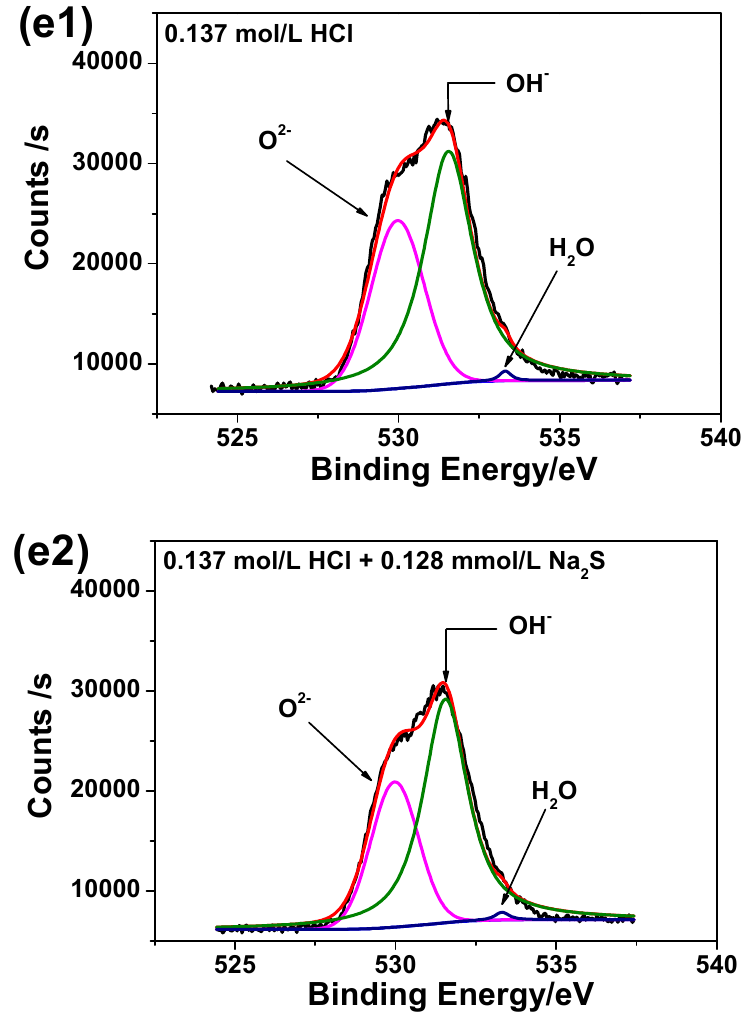
Figure 8. High-resolution scanning XPS spectra of passive films on 2205 DSS surface in 0.137 mol/L HCl solutions at 90 °C for 8 h: ( a1 ) Cr 2p, ( a2 ) Cr 2p, added 0.128 mmol/L Na 2 S, ( b1 ) Fe 2p, ( b2 ) Fe 2p, added 0.128 mmol/L Na 2 S, ( c1 ) Mo 3d, ( c2 ) Mo 3d, added 0.128 mmol/L Na 2 S, ( d1 ) Ni 2p, ( d2 ) Ni 2p, added 0.128 mmol/L Na 2 S, ( e1 ) O1s and ( e2 ) O1s, added 0.128 mmol/L Na 2 S.